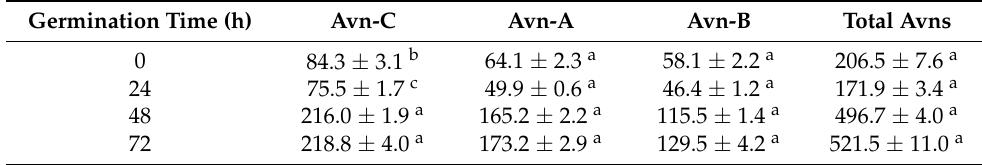
Table 2. Changes in Avn content in germinated oats ( µ g/g).